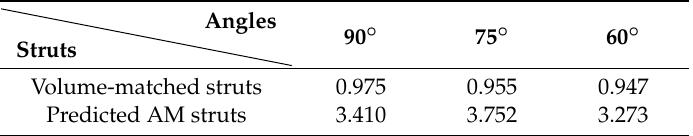
Table 3. Maximum von Mises stress of the volume-matched struts and the predicted AM struts normalized with respect to those of the nominal struts in different printed